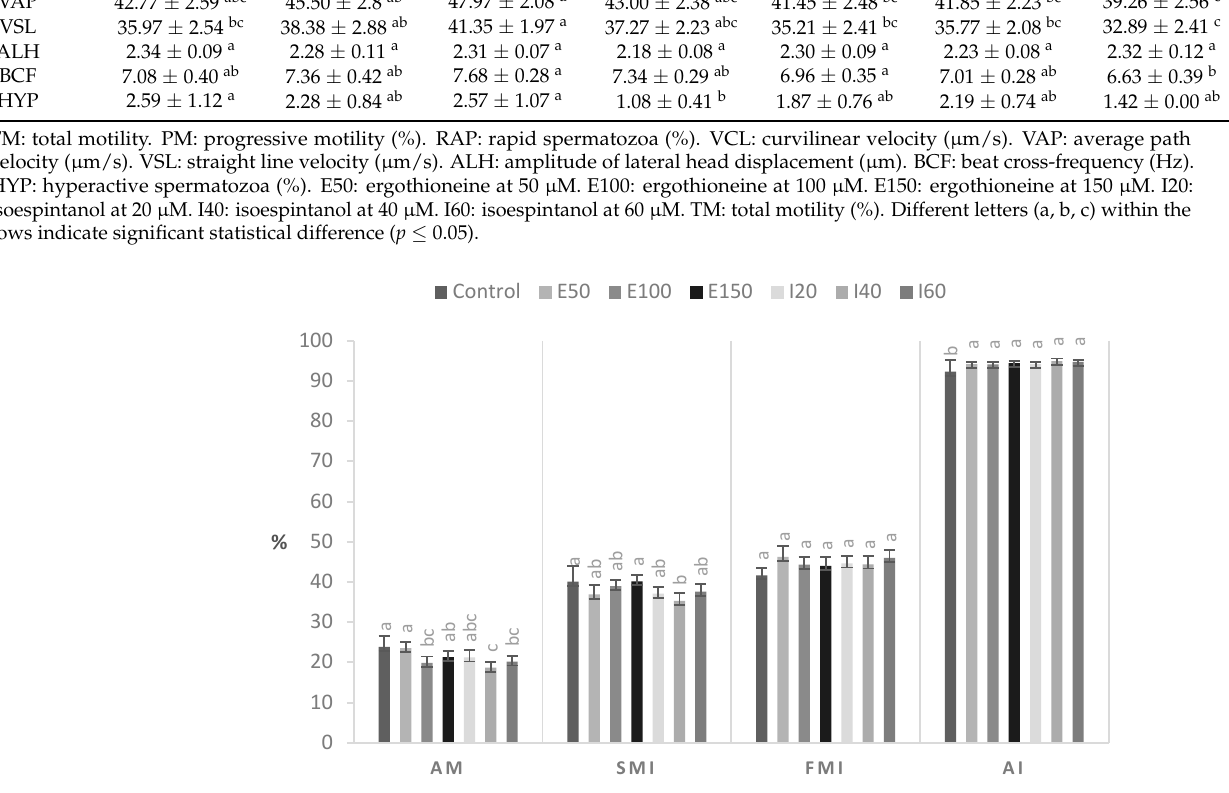
Figure 2. Mitochondrial membrane potential of frozen-thawed canine semen. E50: ergothioneine at 50 µM. E100: ergothioneine at 100 µM. E150: ergothioneine at 150 µM. I20: isoespintanol at 20 µM. I40: isoespintanol at 40 µM. I60: isoespintanol at 60 µM. Low- ΔΨ M: low mitochondrial membrane potential. High- ΔΨ M: high mitochondrial membrane potential. RFU: relative fluorescence units. Bars represent the mean ± standard error of the mean (SEM). No significant statistical differences were found ( p ≥ 0.05).